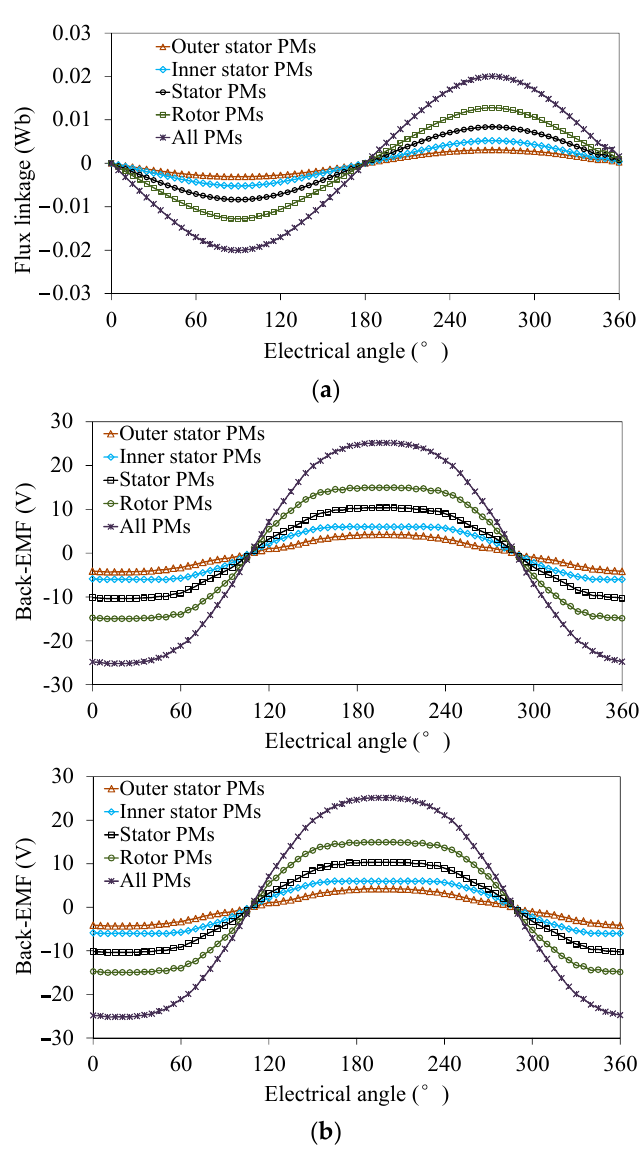
Figure 12. Flux linkage and back-EMF in secondary windings due to different excitation sources. ( a ) Flux linkage; ( b ) back-EMF.